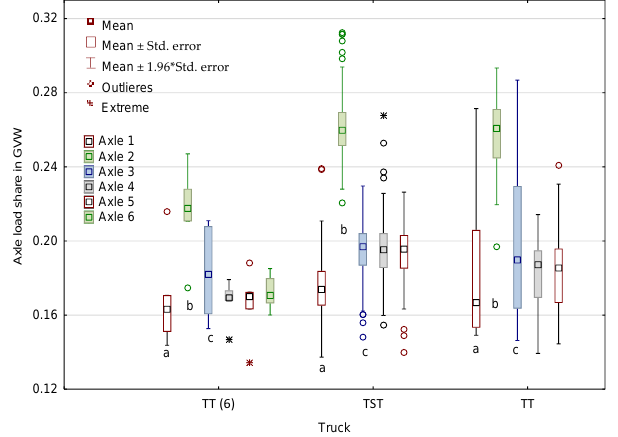
Figure 8. Distribution of the total gross vehicle weight of the transport set on its axles. Groups with similar lower-case letters (a, b, c, under the box plots) indicate significant similarities, according to a Kruskal–Wallis test or Dunn’s multi-sample rank mean comparison test. Table 3. Spearman correlation coefficients between the axle load and the